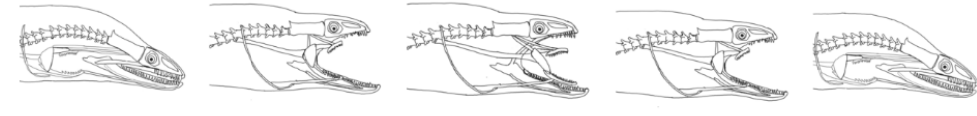
Table 1. Approximation of the different poses of the oral jaw and the pharyngeal jaw during hunt- ing.